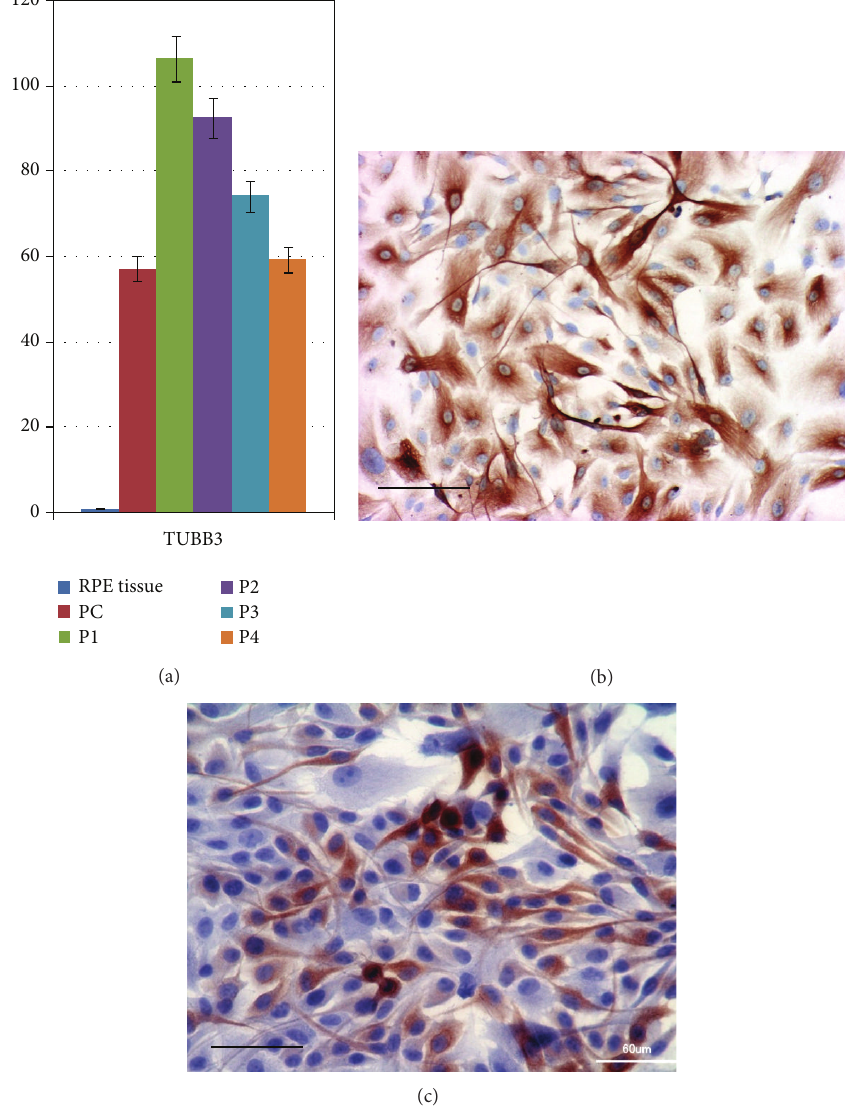
Figure 1: Some characteristics of adult human RPE cells in vitro . (a) The results of real-time PCR analysis of TUBB3 expression in primary culture (PC) and subsequent passages (P1–P4) of RPE cells in adhesive monolayers, compared to freshly isolated RPE (RPE Tissue). (b) Immunoperoxidase staining for TUBB3 (brown) in passage 2 RPE cells. (c) Immunoperoxidase staining (brown) for neurofilaments 68 and 200 in passage 4 RPE cells. Cell nuclei are stained with hematoxylin. Scale bar, 60 𝜇